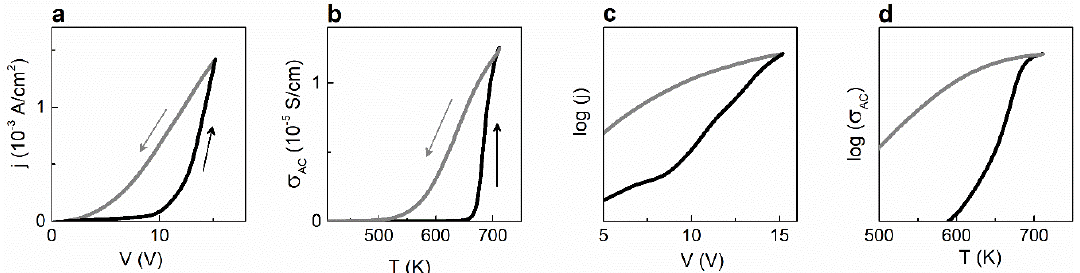
Figure 5. Electric conduction. ( a , b ) Linear and ( c , d ) semi-log plots of ( a , c ) current density while sweeping the DC voltage and ( b , d ) AC conductivity during heating and cooling. Arrows show directions of the parameter change in ( a , b ). Plots are based on data reported in [47,48].